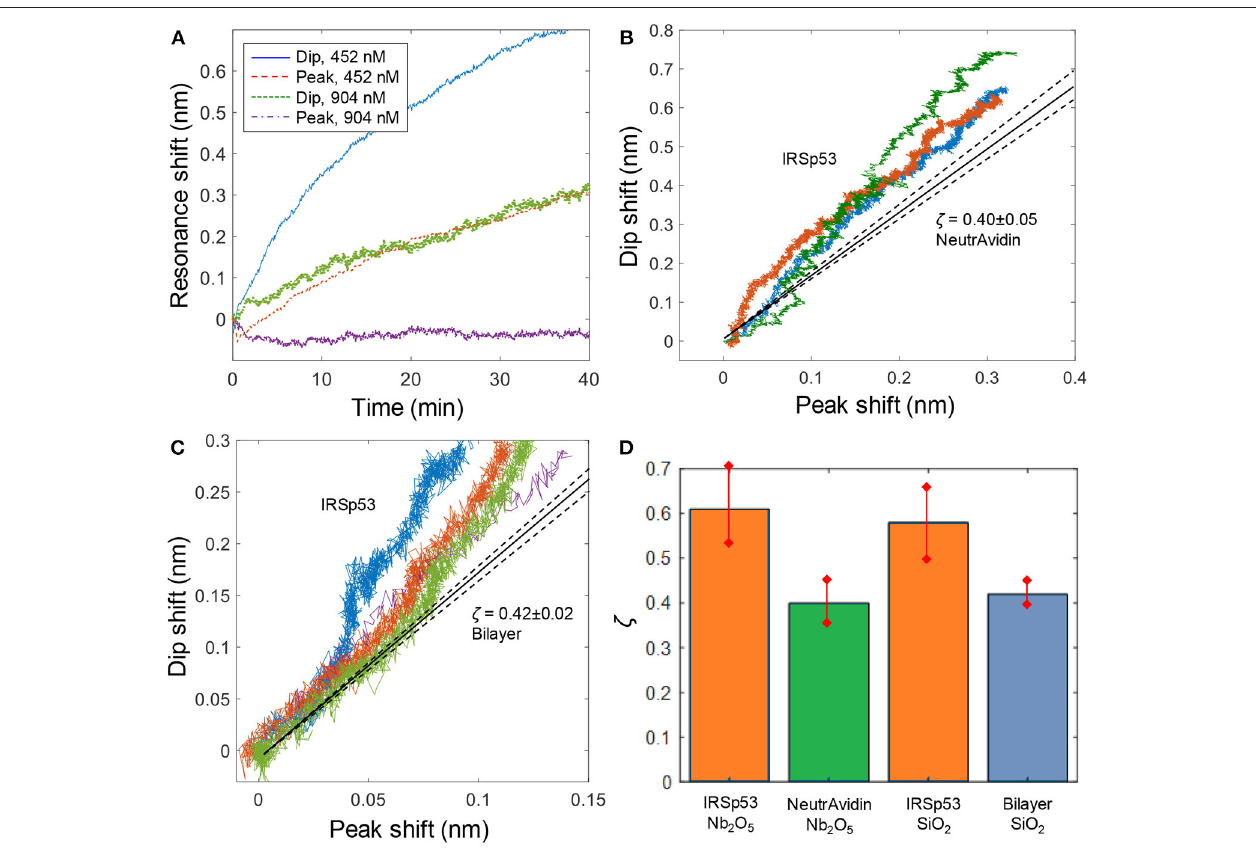
FIGURE 4 | IRSp53 binding with negative curvature preference. (A) Kinetics of IRSp53 binding (introduced at 0min) to membranes with negative lipids on Nb 2 O 5 nanowells. For the lower concentration no peak shift is detected. (B) Dip and peak signals for IRSp53 compared to NeutrAvidin binding to Nb 2 O 5 nanowells. (C) Dip and peak signals for IRSp53 compared to bilayer formation on SiO 2 nanowells. (D) Summary of ζ values with error margins. For Nb 2 O 5 nanowells, NeutrAvidin is used as the reference and for SiO 2 nanowells, the preceding bilayer is used.